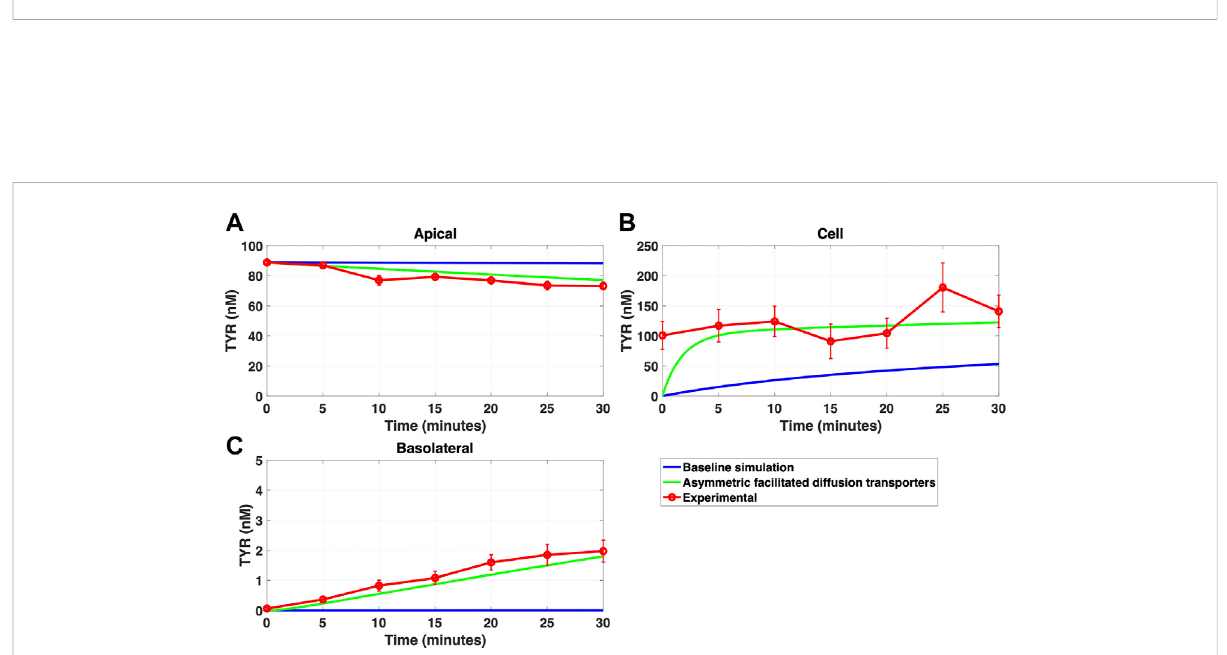
FIGURE 9 Introduction of asymmetry in the apical membrane OCT2 successfully recapitulates experimental observations following apical TYR loading. The transport of 88.9 nM of TYR across Caco-2 cells was modeled following apical loading by solving Eqs 9 – 11, using the values mentioned in Supplementary Table S2, using MATLAB vR 2021a. Comparisons were made between the models (baseline = blue curve; modi fi ed = green curves) and experimental observations; red curve (Sarkar and Berry, 2020) for the apical Panel 9 (A) , cellular (Panel 9 (B) and basolateral compartments (Panel 9 (C) . The model reproduced experimental fi ndings when asymmetric OCT2 transport was combined with a fully bidirectional basolateral membranefacilitateddiffusiontransporter. Solvedkineticparametersfromthismodellingwere:V max_OCT2 =2.3 nM/s,K t_OCT2_apicaltocell =110.4nM, K t _OCT2_celltoapical = 1,227.9 nM, V max_baso_active = 3.3 nM/s, K t_baso_active = 29.0 nM, V max_baso_new_FD = 6.0 nM/s, K t_baso_new_FD_basotocell = 584.1 nM and K t_baso_new_FD_celltobaso = 672.4